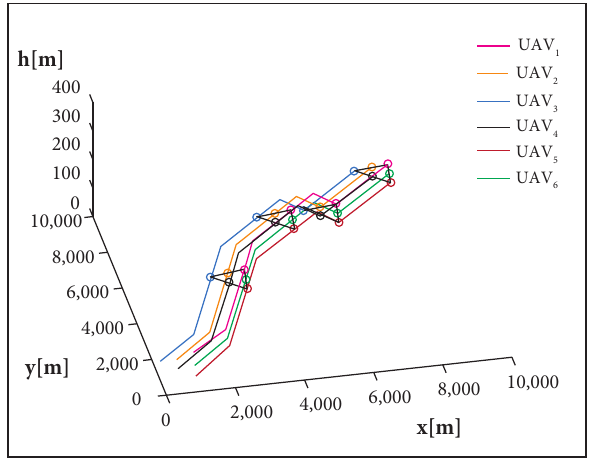
figure 3. Communication topology of UAVs. figure 5. 3-D trajectories of UAVs’ formation